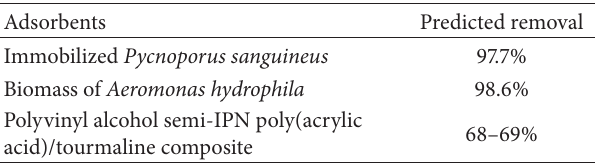
Table 4: Predicted removal from the design experiments for the removal of lead by the use of other